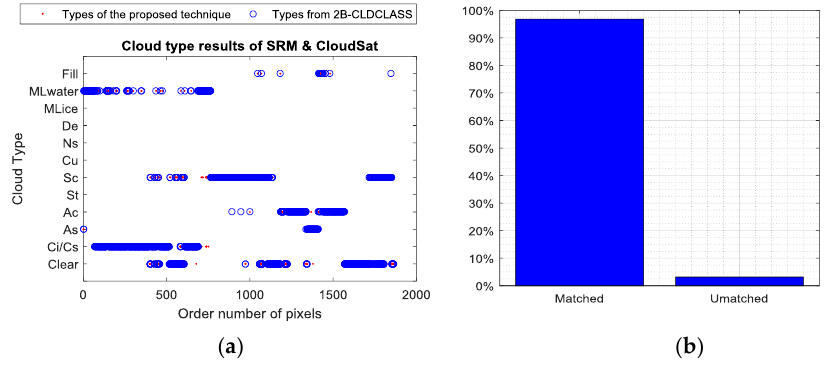
Figure 14. Results of the proposed technique and cloud types from 2B-CLDCLASS [7,40] under the condition that cloud types of potential CPR pixel with the same position information are probably used as those of recipient pixels. ( a ) is scattered distribution, where points are cloud types of the proposed technique while circles stand for types from 2B-CLDCLASS. ( b ) is statistical distribution, “Matched” means that the same type is determined by both methods whereas “Unmatched” means that different types are classified.